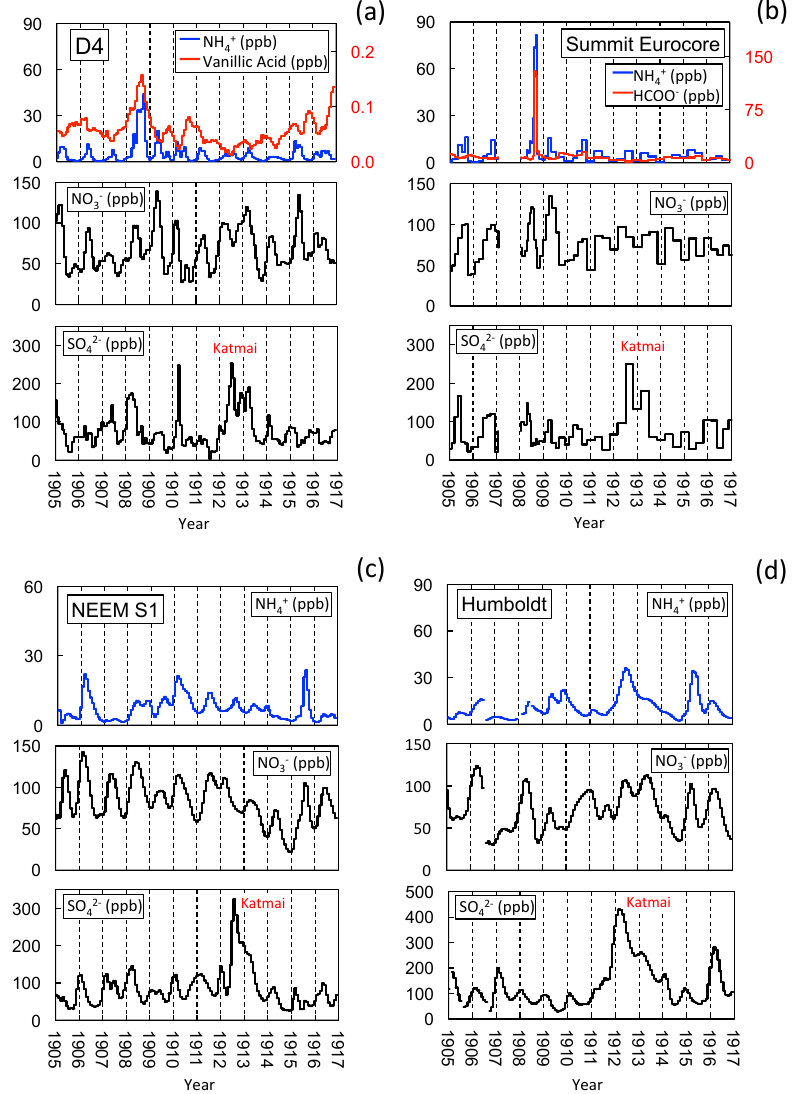
Figure A1. High-resolution 1905–1916 records of ammonium, nitrate, and sulfate at D4 (a) , Summit (GRIP 93) (b) , NEEM-2011-S1 (c) , and Humboldt (d) . At Summit and D4, data on carboxylic acids also were available, formate at Summit (Legrand and De Angelis, 1998), and vanillic acid at D4 (McConnell et al., 2007). Note the presence of the Katmai volcanic layer (1912) in the sulfate records, permitting accuracy of the dating to be <1 year during this sequence of